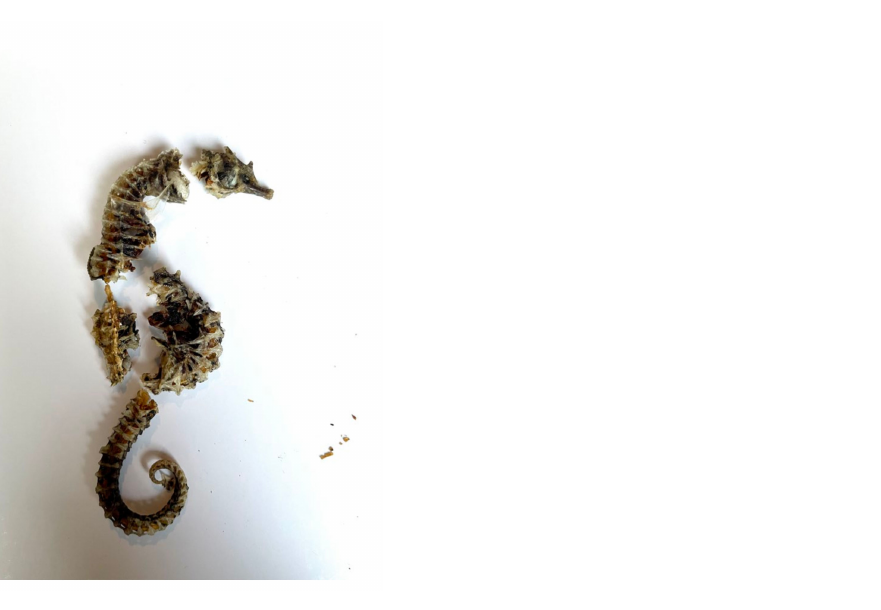
Figure 6. Individual of Hippocampus hippocampus found in one adult female from the Tyrrhenian